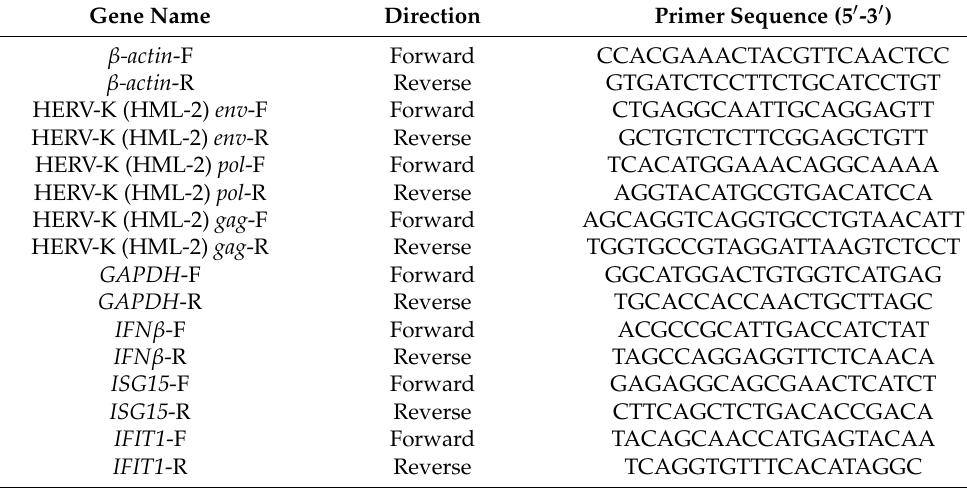
Table 1. Primers used in this